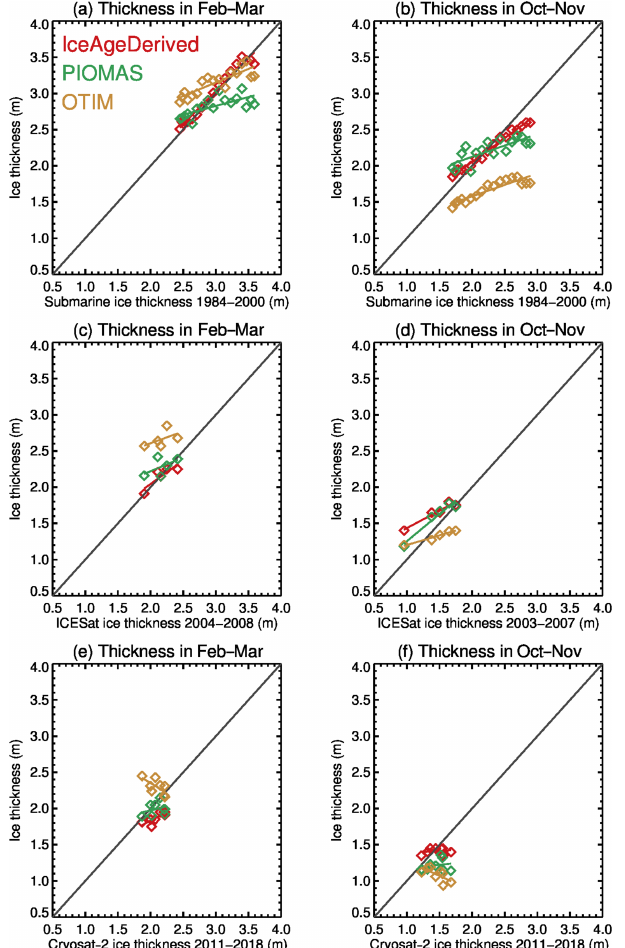
Figure 5. Comparison of ice thickness from the IceAgeDerived product, PIOMAS, and OTIM to ice thickness from subma- rine upward-looking sonar (1984–2000), ICESat (2004–2008), and CryoSat-2 (2011–2018) over the SCICEX data release area.